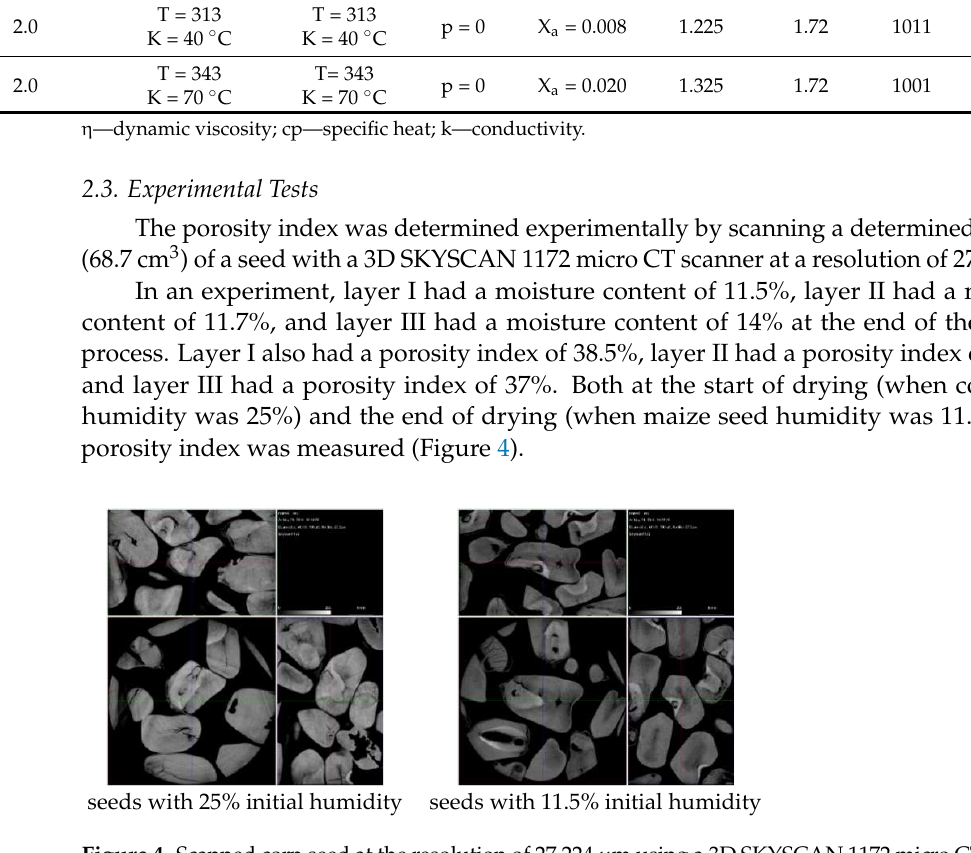
Figure 4. Scanned corn seed at the resolution of 27,224 μm using a 3D SKYSCAN 1172 micro CT scanner.